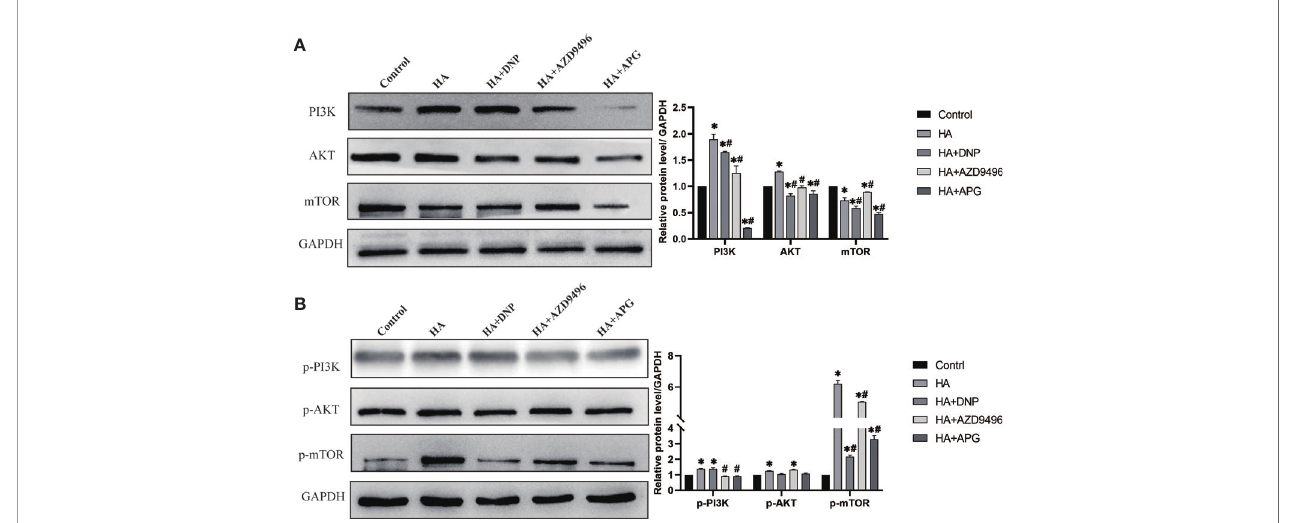
FIGURE 5 | Apigenin inhibits ovarian cancer induced by histamine through attenuating PI3K/AKT/mTOR pathway. (A) Western blot analysis of PI3K, Akt and mTOR expression level of differently-treated OVCAR-3 cells. (B) Western blot analysis of p-PI3K, p-Akt and p-mTOR expression level. * P < 0.05 (Compared to untreated OVCAR-3 cell group); # P < 0.05 (compared with the HA-treated